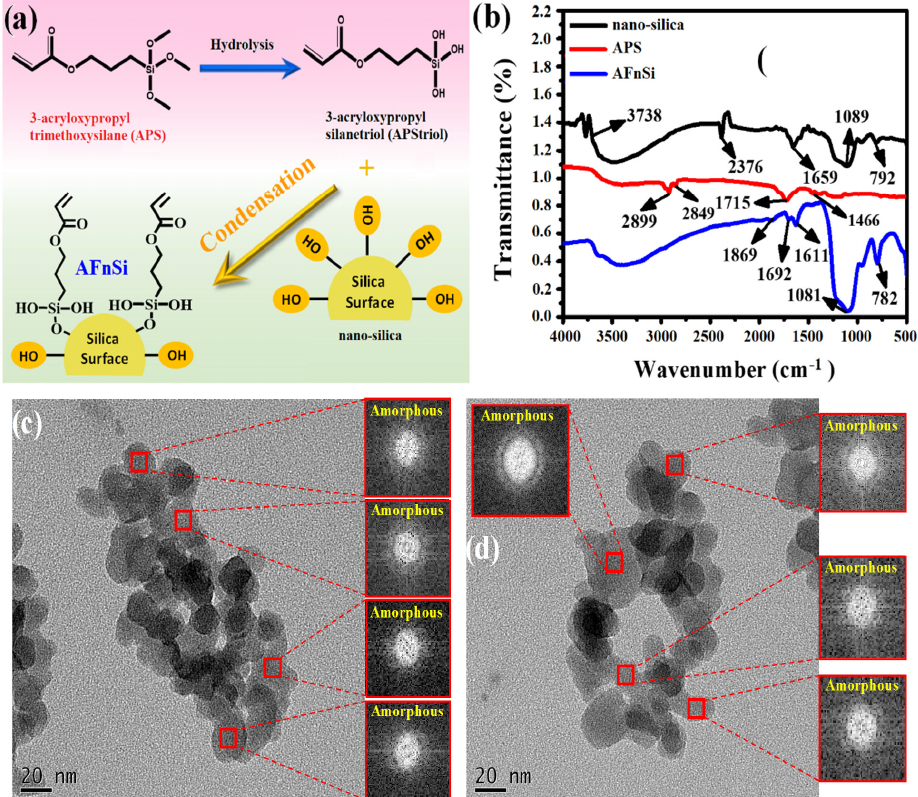
Figure 4. The scheme of AFnSi crosslinker synthesis ( a ); FTIR spectrum of nano–silica, 3–acryloxypropyl trimethoxysilane (APS), and acrylate functionalized nano-silica (AFnSi) ( b ); the TEM images and diffraction patterns of nano-silica ( c ); AFnSi ( d